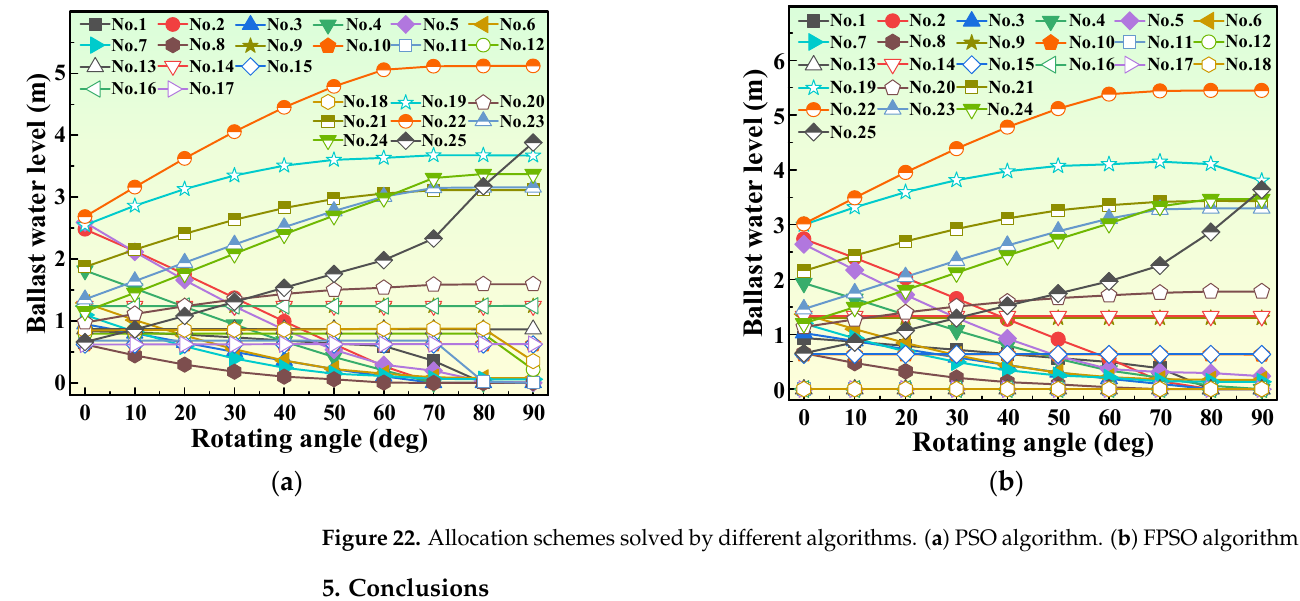
Table 6. Calculation results of different solving algorithms for the RFC with 25 ballast tanks. Solving Algorithm